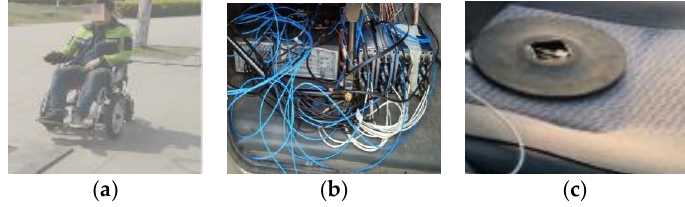
Figure 4. Pulse test: ( a ) the test field; ( b ) the test equipment LMS Test.Lab; ( c ) the set up of the test.